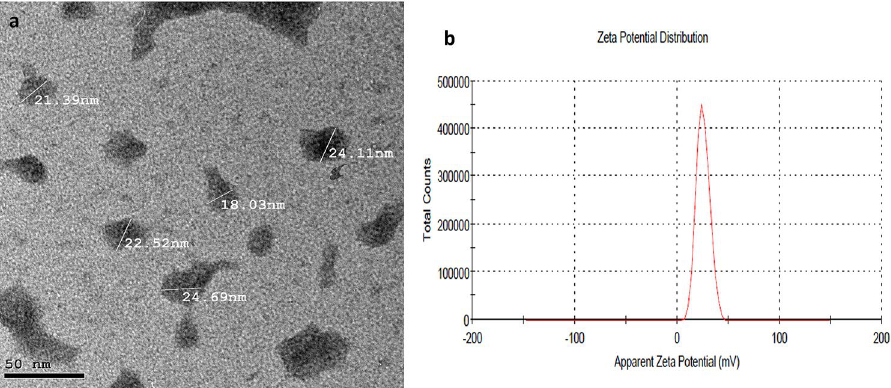
Figure 11. Transmission electron microscopy ( A ) and zeta potential distribution ( B ) of B. amyloliquefaciens loaded